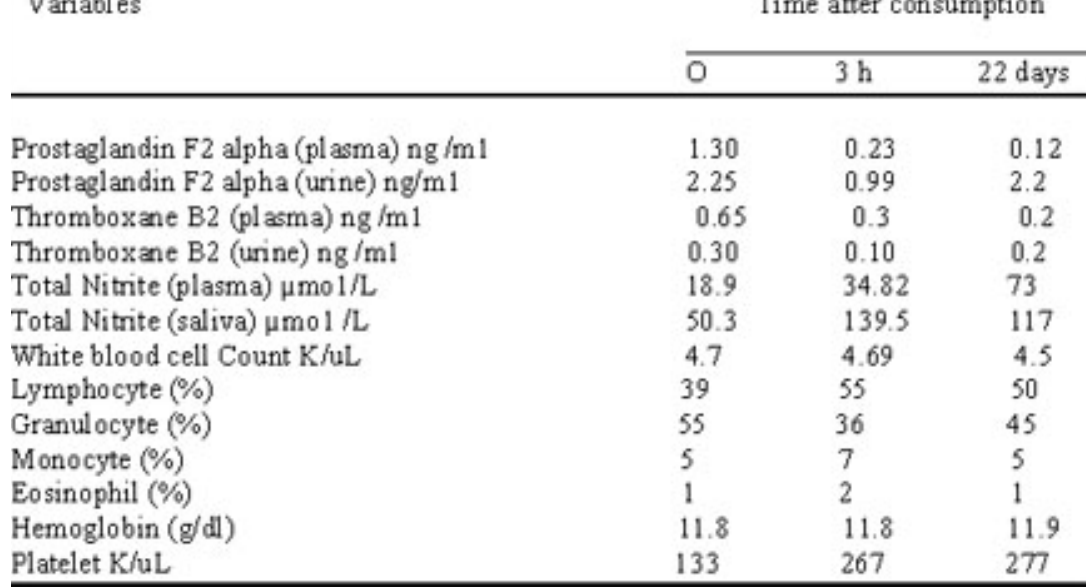
blood indices in the patient with